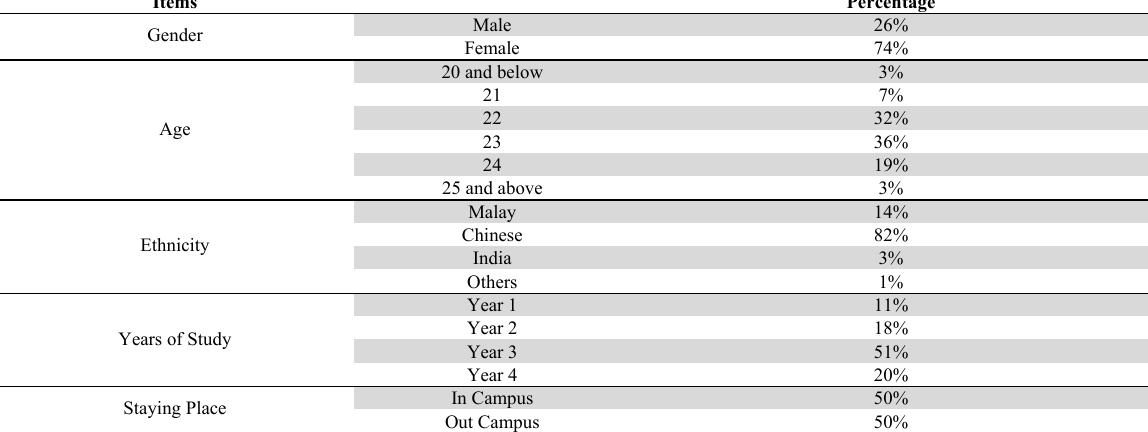
Demographic profile of respondents based on gender, age, ethnicity, years of study and staying place Items